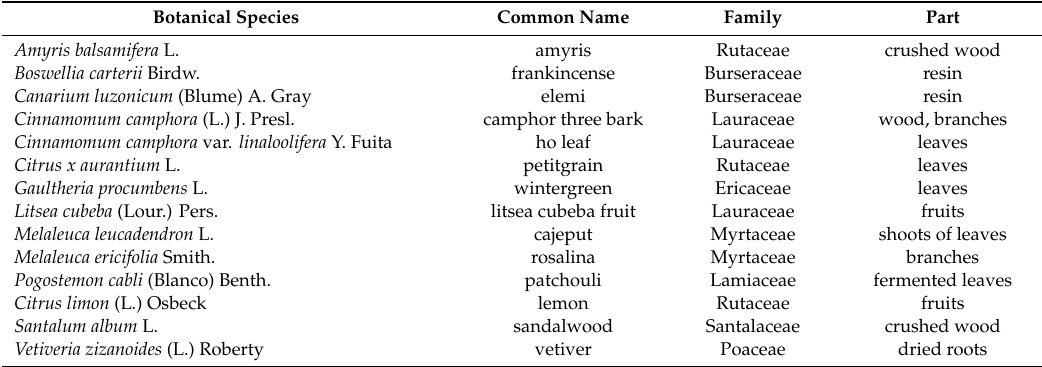
Table 8. List of essential